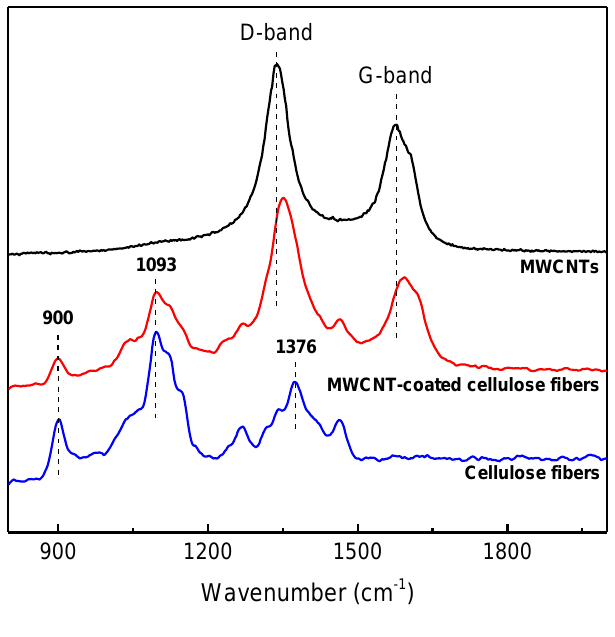
Figure 2. Raman spectra of the pristine MWCNTs, cellulose fibers and MWCNT-coated cellulose